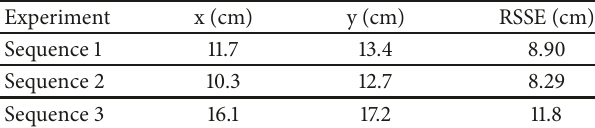
Table 3: Mean localization interval error and